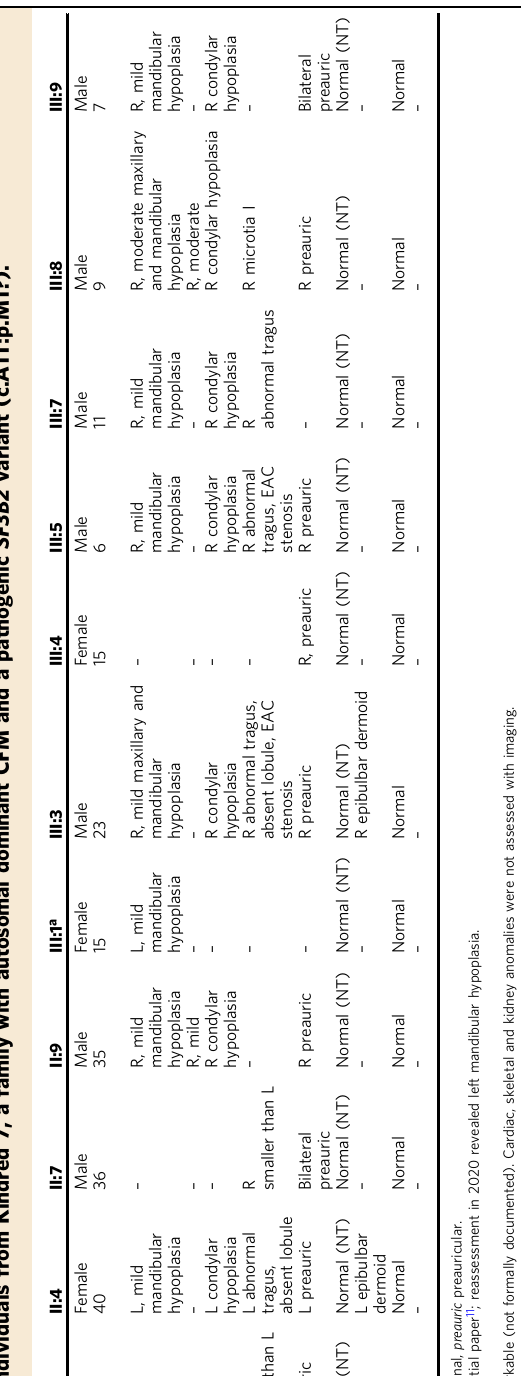
Table 4 De novo and transmitted LOF variants in